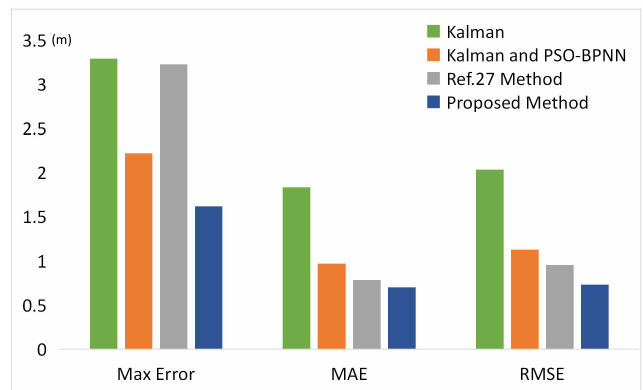
Figure 12. Comparison of the positioning RMSE, MAE ,and maximum error between the traditional and proposed